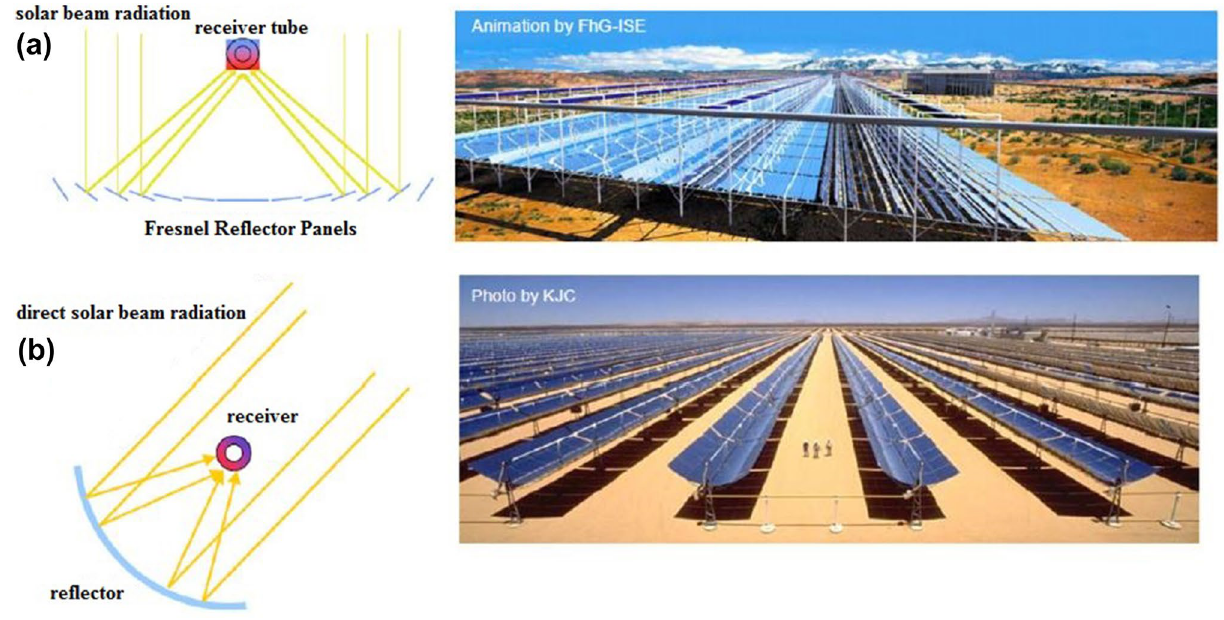
Fig. 31 Fresnel collectors (a) and parabolic trough (b) (El-Ghonemy 2012)